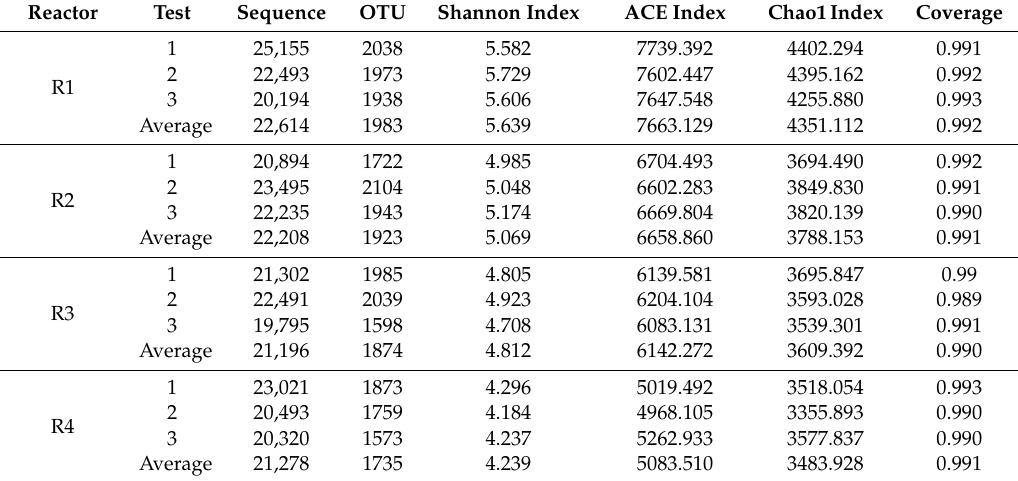
Table 1. The Alpha diversity of the four activated sludge